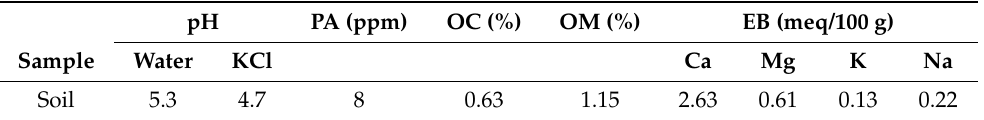
Table 2. Mean value (±standard error) of the effect of chitosans produced in combination with P. putida on maize plant Table 1. Chemical characteristics of the used soil for maize grow. growth parameters.